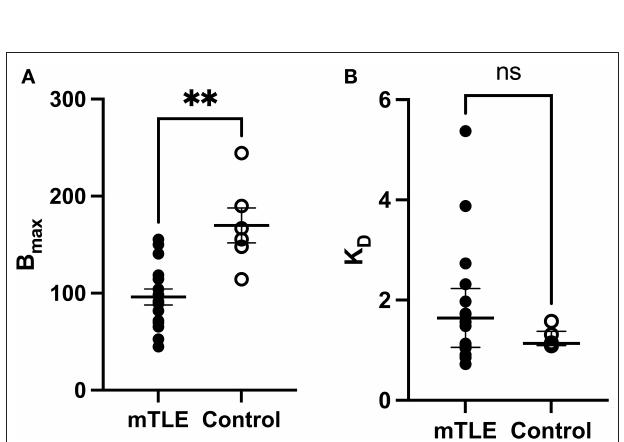
FIGURE 2 | [ 3 H]ABP688 B max and K D values in the hippocampus. Receptor densities (B max ; in fmol/mg) and dissociation constants (K D ) in hippocampal specimens from mesial temporal lobe epilepsy (mTLE) patients and healthy control individuals. (A) B max values were reduced in mTLE patients compared to controls. Values are represented as mean ± std. error. (B) Dissociation constants were not significantly altered in mTLE patients compared to controls. Values are represented as median with interquartile range. ** p < 0.01; ns, indicates a non-significant comparison.